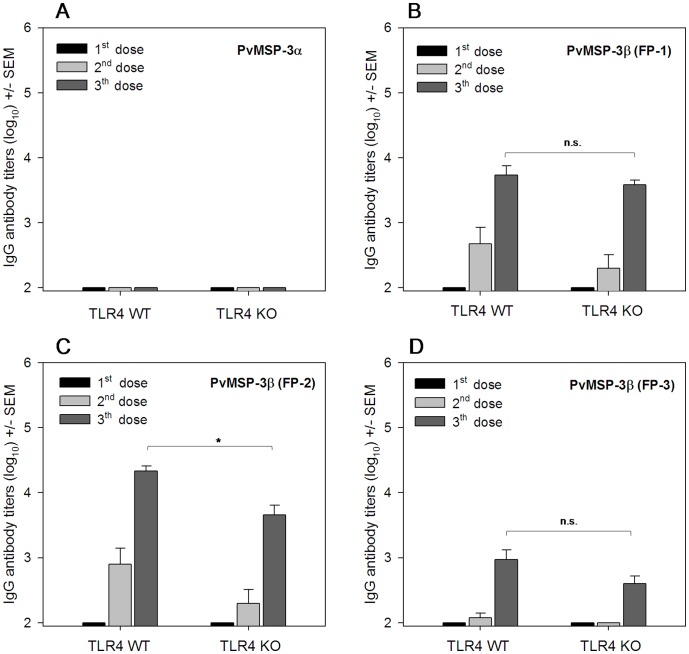
IgG antibody response in C57BL/6 wild-type (WT) and TLR4 KO mice after immunization with MSP-3 in the absence of adjuvant.Groups of 5 mice were immunized 3 times (s.c.) with 10 µg of PvMSP-3α, PvMSP-3β (FP-1), PvMSP-3β (FP-2), or PvMSP-3β (FP-3) and antibody titers to homologous PvMSP-3 were determined after each dose. Results are expressed as the means of antibody titers (log10) ± SEM and were compared by one-way ANOVA followed by Tukey’s test for multiple comparisons. After the third dose, non-significant differences between groups of immunized mice (C57BL/6 WT vs. TKR4 KO) are denoted on the graph as “n.s.” Significant difference between 2 groups of mice immunized with 3 doses of PvMSP-3β (FP-2) are denoted on the graph (*p<0.05).